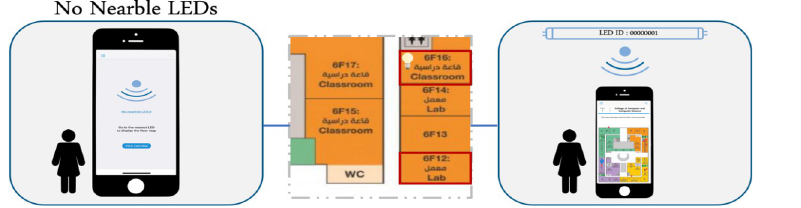
Fig 6. The user inside the light-emitting diode (LED) range.